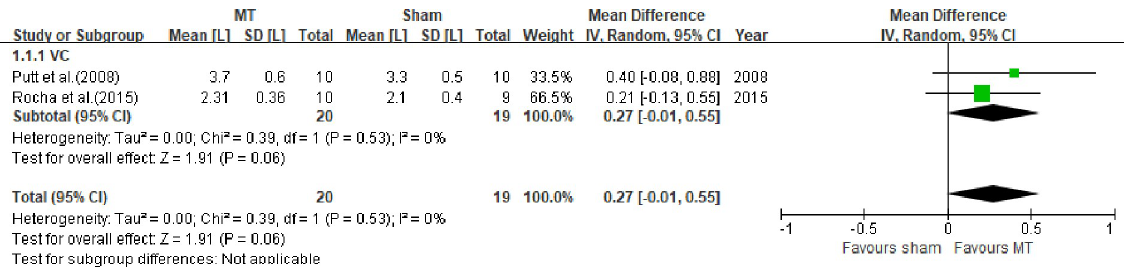
Fig 4. Forest plots for comparison of vital capacity (VC) between manual therapy (MT) and